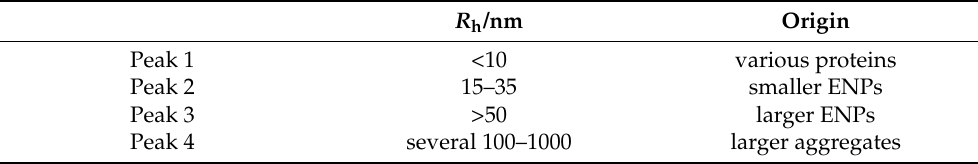
Table 1. The mean R h values for the peak positions in size distributions of plasma, ascites, and filtered ascites (ascitesF) of ovarian cancer patient OC1 determined at θ = 90 ◦ and T = 25 ◦